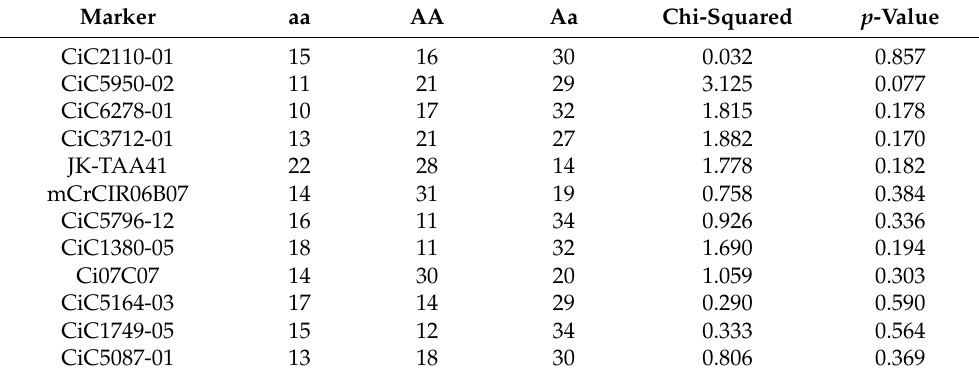
Table 3. Analysis of Mendelian allelic segregation (Chi-squared test with Bonferroni correction for multiple testing) of the recovered plants from the self-pollinated buds of the ‘Clemenules’ clementine. Marker aa AA Aa